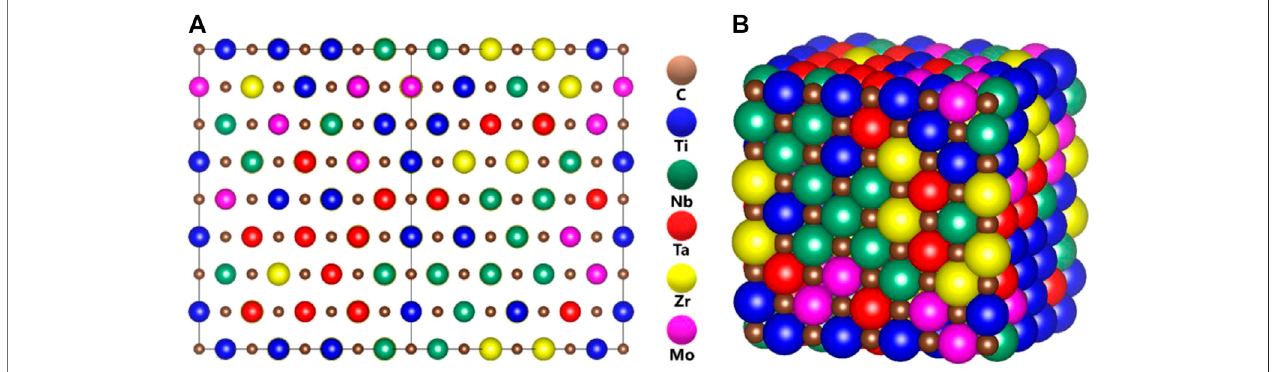
FIGURE 1 | Illustration of disordered solid solution alloys of TiNbTaZrMo-C models (A) balls, and (B) space- fi lling.